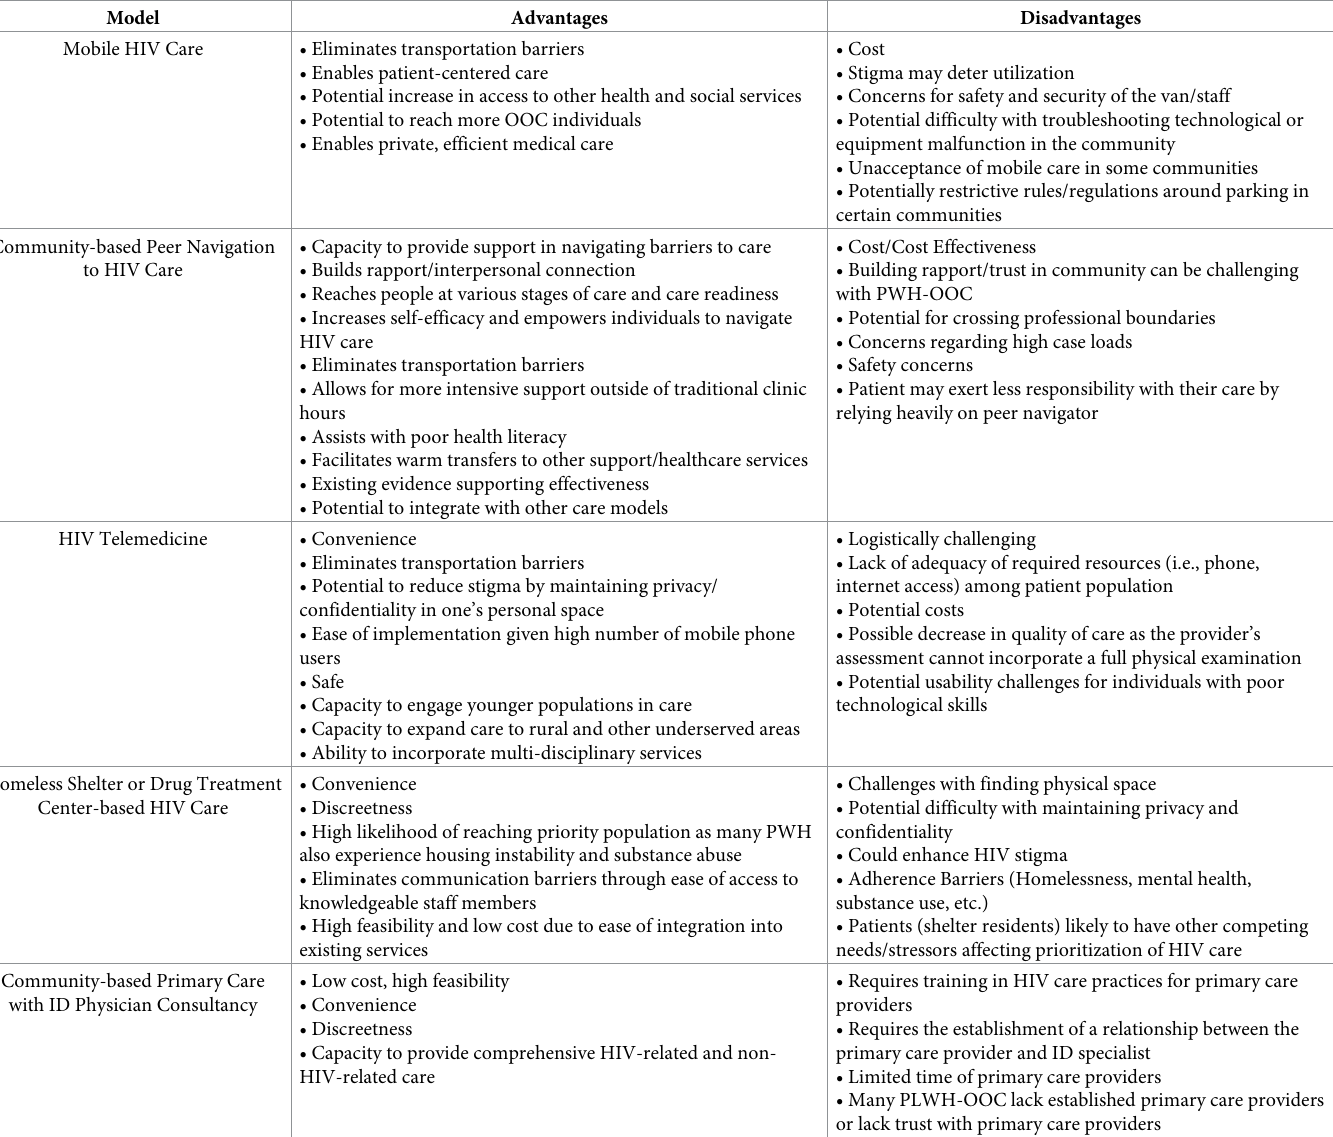
Table 2. Perceived advantages and disadvantages of community-based HIV care models across HIV care stakeholders (n = 41 key informants).